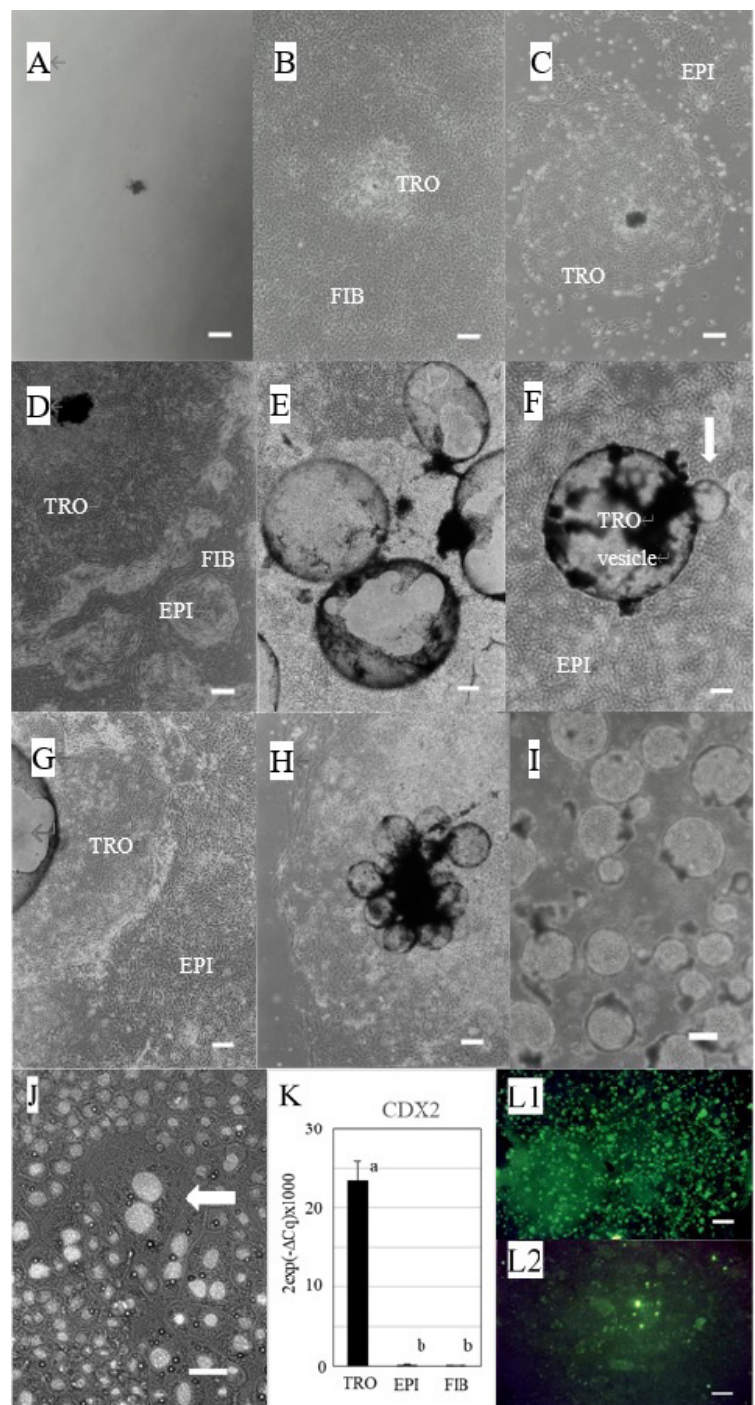
Figure 1. Preparation of trophoblast cells derived from bovine blastocyst. (A) Regressed blastocyst (day 5 of culture), (B) TRO in a culture of FIB derived from the placentome (day 30 of culture), (C) TRO in a culture of uterine epithelial cells (day 5 of culture), (D) TRO in a mixed culture of uter- ine EPI and FIB derived from the placentome (day 5 of culture), (E) Formation of vesicles (day 25 of culture), (F) Formation of baby vesicles (white arrow) on the surface of trophoblast vesicle in EPI culture (day 13 after transplantation). (G) Formation of the trophoblast colony in EPI culture (day 33 of culture), (H) Trophoblasts colony without feeder cells (day 22 after transplantation), (white bars in A-H: 200 μm). (I) Floating vesicles (white bar: 100 μm). (J) Hoechst staining + phase-contrast image. White arrow shows a binucleate cell, (white bar: 50 μm). (K) qPCR results of CDX2 gene expression (TRO: n = 5, EPI: n = 3, FIB: n = 3). TRO, trophoblast colony; FIB, fibroblasts; EPI, epithelial cells; CDX2, caudal type homeo - box 2. a,b Different lowercase letters indicate statistically significant differences among cell types (p<0.001). (L1, L2) Immunostaining (white bar: 100 μm). L1, cytokeratin; L2,